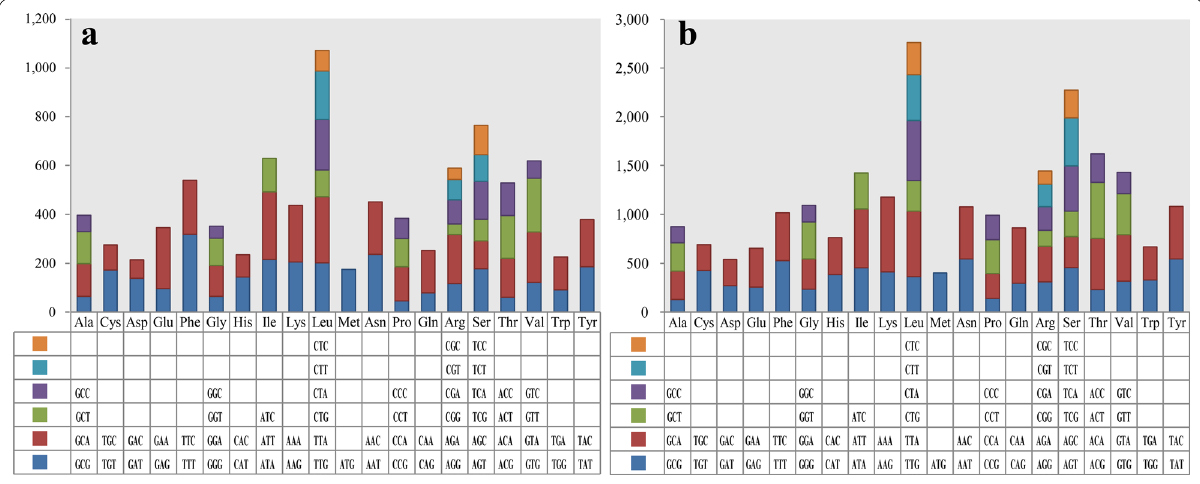
Fig. 3 Codon usage in the mitochondrial genomes of two Filobasidium species. Frequency of codon usage is plotted on the y-axis. a , F. wieringae ; b , F.